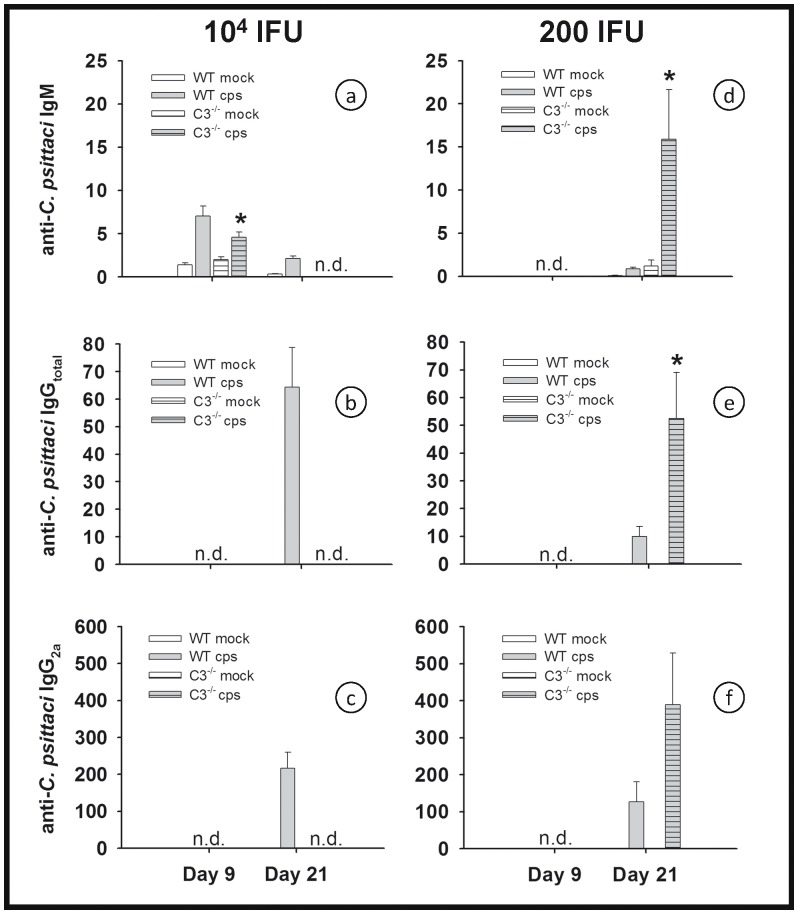
Figure
9. C3−/− mice raise almost normal levels of anti-chlamydial antibodies in low-dose
C. psittaci
 infection. C3−/− and the corresponding BL/6J WT mice were infected with 104 (panel a–c) or 200 IFU (panel d–f) of C. psittaci DC15. Anti-chlamydial IgM (panel a and d), total IgG (panel b and e) and IgG2a (panel c and f) were determined in serum obtained 9 or 21 days p.i. as indicated. All C3−/− mice infected with 104 IFU died before day 21 and were not available for examination (n.d.). Depicted are the means ± SEM. * indicates significant differences (p<0.05) between infected knockout mice as compared to the corresponding infected BL/6J WT mice.